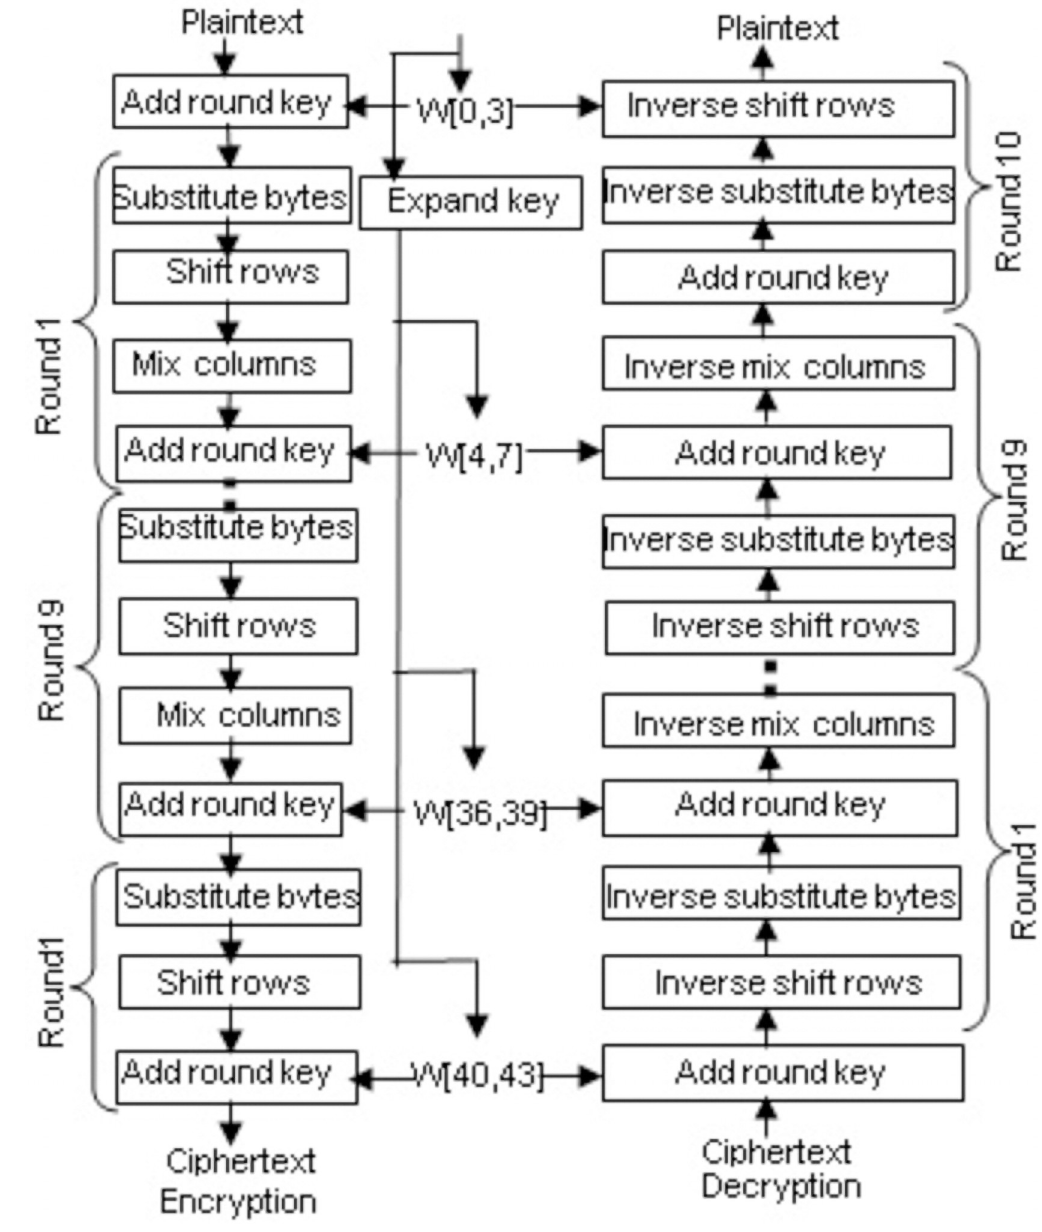
Fig 1. AES encryption and